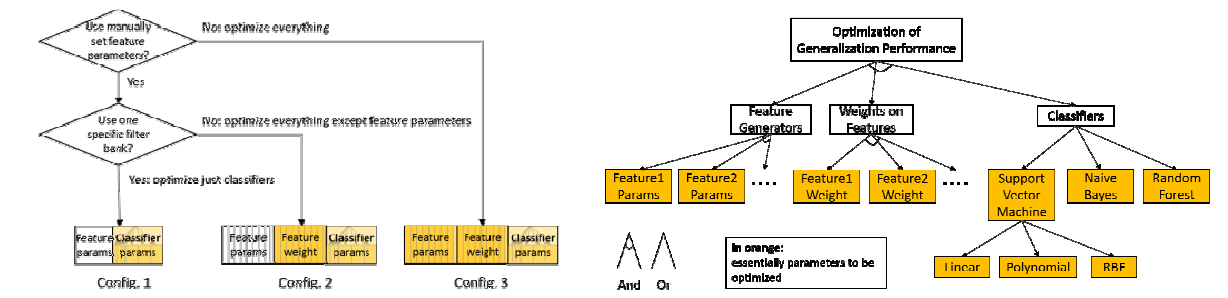
Figure 1. Three levelled configurations Figure 2. Optimization over a whole learning pipeline